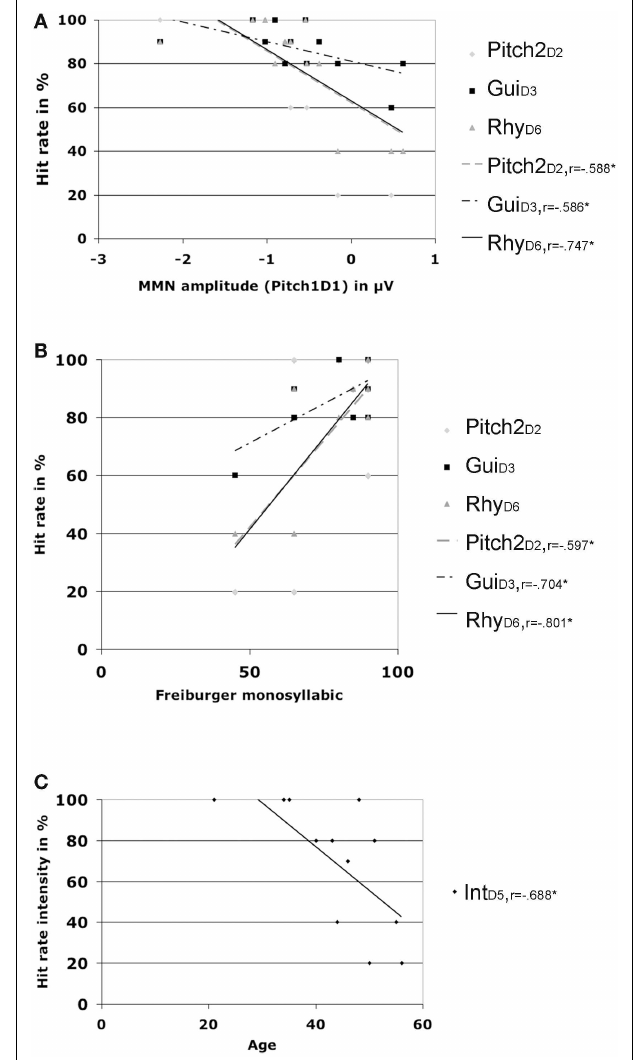
FIGURE 4 | Hit rates and correlations. (A) Correlations of different hit rates with MMN amplitude for deviation Pitch1 in CI users. (B) Correlations of different hit rates with the Freiburger monosyllabic speech scores in CI users. (C) Correlations of hit rates for intensity with age in CI users.